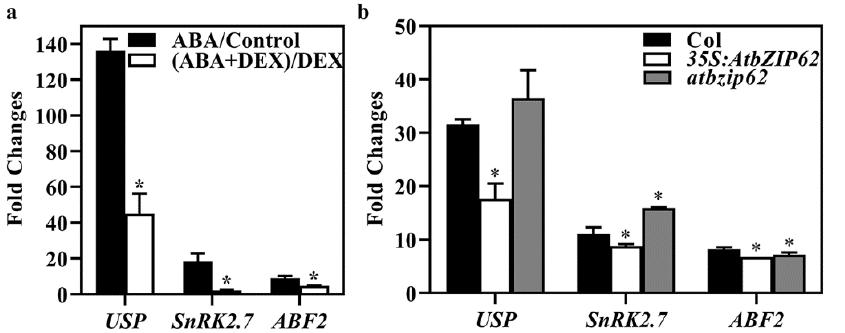
Figure 7. AtbZIP62 affects ABA-induced expression of USP , SnRK2.7, and ABF2 . ( a ) ABA-induced expression of USP , SnRK2.7, and ABF2 in ABA and ABA + DEX treated 35S:AtbZIP62-GR transgenic plant seedlings. Ten-day-old seedlings of 35S:AtbZIP62-GR transgenic plants were treated with 50 μM ABA in the presence and absence of 10 μM DEX for 4 h. RNA was then isolated and used for qRT-PCR analysis. ACT2 was used as an inner control, and fold changes were calculated by comparing the expression levels of the corresponding genes in ABA-treated with control seedlings in the presence and absence of DEX, respectively. Data represent the mean ± SD of three replicates. * significantly different from ABA-treated seedlings (student’s t -test, p < 0.005). ( b ) ABA-induced expression of USP , SnRK2.7, and ABF2 in the 35S:AtbZIP62 transgenic plant and atbzip62 mutant seedlings. Seedlings of 10-days-old Col wild type, the 35S:AtbZIP62 transgenic plants, and the ztbzip62 mutants were treated with 50 μM ABA for 4 h. RNA was then isolated and subjected to qRT-PCR analysis. ACT2 was used as an inner control, and fold changes were calculated by comparing the expression levels of the corresponding genes in ABA-treated with control seedlings. Data represent the mean ± SD of three replicates. * significantly different from that in the Col wild-type seedlings (student’s t -test, p < 0.05).